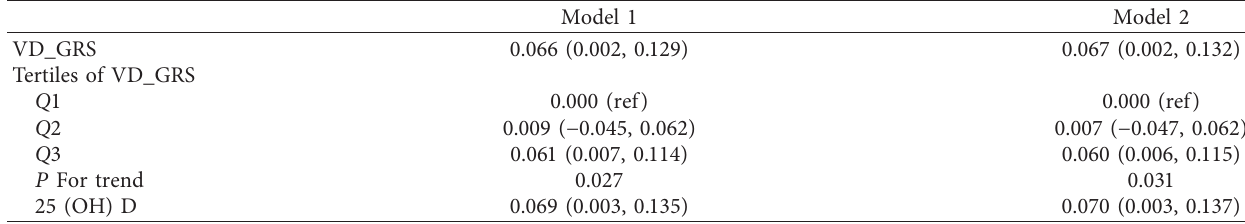
Table 5: Associations of VD_GRS and 25 (OH) D with TPOAb concentration.